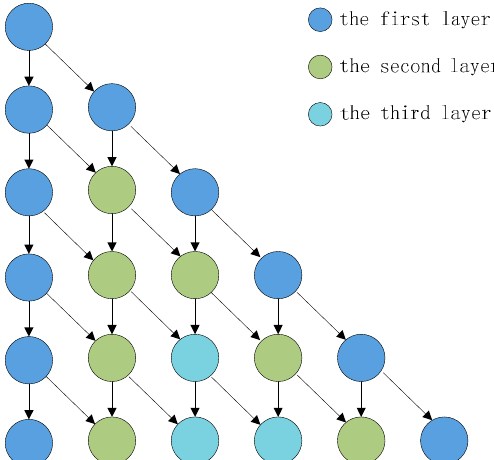
Figure 13. A schematic diagram of the Matryoshka doll algorithm. For every cycle, the data involved in the operation moves from the outer to inner layers, which is similar to the nested form of the Matryoshka doll.